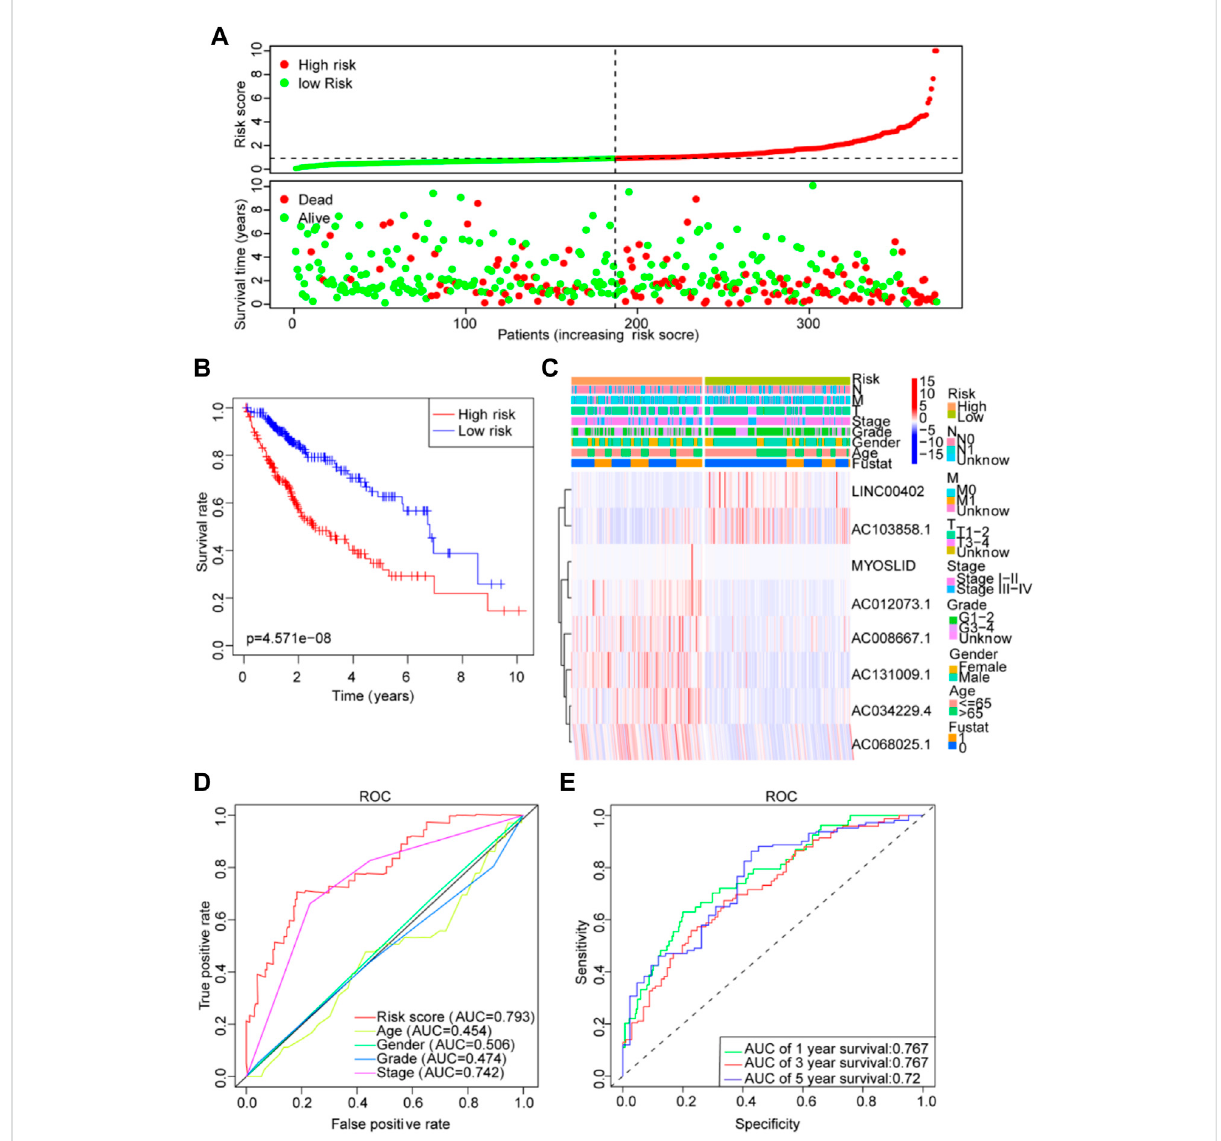
FIGURE 6 Lactate lncRNA signature based on TCGA. (A) Risk score distribution and survival status of the two risk groups. (B) Kaplan-Meier curve analysis for the cohort. (C) Heatmap for the lactate lncRNA prognostic signature and clinicopathological manifestations. (D) Timedependent receiver operatingcharacteristic(ROC)analysisfor1-yearoverallsurvival(OS)basedoneightlactatelncRNAswerecomparedtoage,sex,grade,TNMstage,T stage, N stage, and M stage. (E) ROC analysis of the lactate prognostic signature at the 1-, 3-, and 5-year